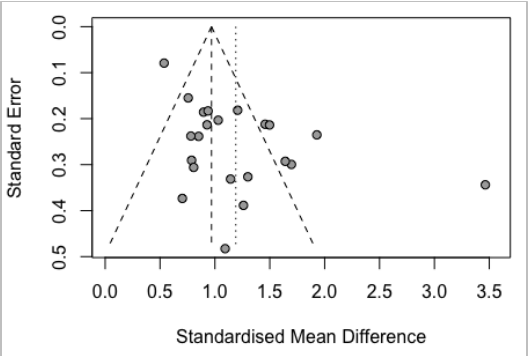
Figure A2. There are a couple of studies outside the confidence bounds for a fixed effect model, including an outlier, but the studies are somewhat balanced on either side of the effect estimates. So, the funnel plot does not reveal an obvious presence of publication or other bias for stable MCI versus MCI_AD.